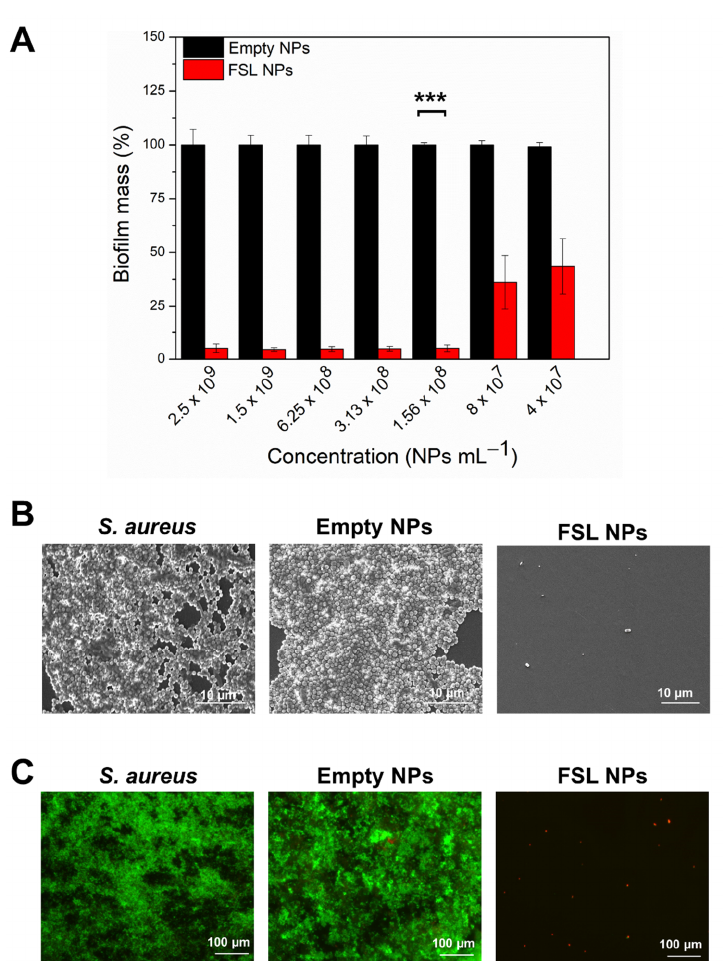
Figure 4. Inhibition of formation of S. aureus biofilm. ( A ) Total biofilm quantification determination of the NPs using crystal violet assay. ( B ) SEM observation of established biofilm with and without incubation with empty and FSL NPs at the same concentration (1.56 × 10 8 NPs mL −1 ). ( C ) LIVE/DEAD BacLight kit microscopic visualization of treated and non-treated S. aureus biofilm with developed NPs at the same concentration (1.56 × 10 8 NPs mL −1 ). The green and red fluorescence images are overlaid. The dead bacteria are stained in red and live bacteria are stained in green. Stars represent the statistical differences between the biofilm inhibition activities of FSL NPs at MBIC and empty NPs ( p < 0.0001). structures, not affected by the empty NPs, whereas the FSL NPs reduced the bacterial cell viability and impaired biofilm formation (Figure 4B). These results were confirmed by